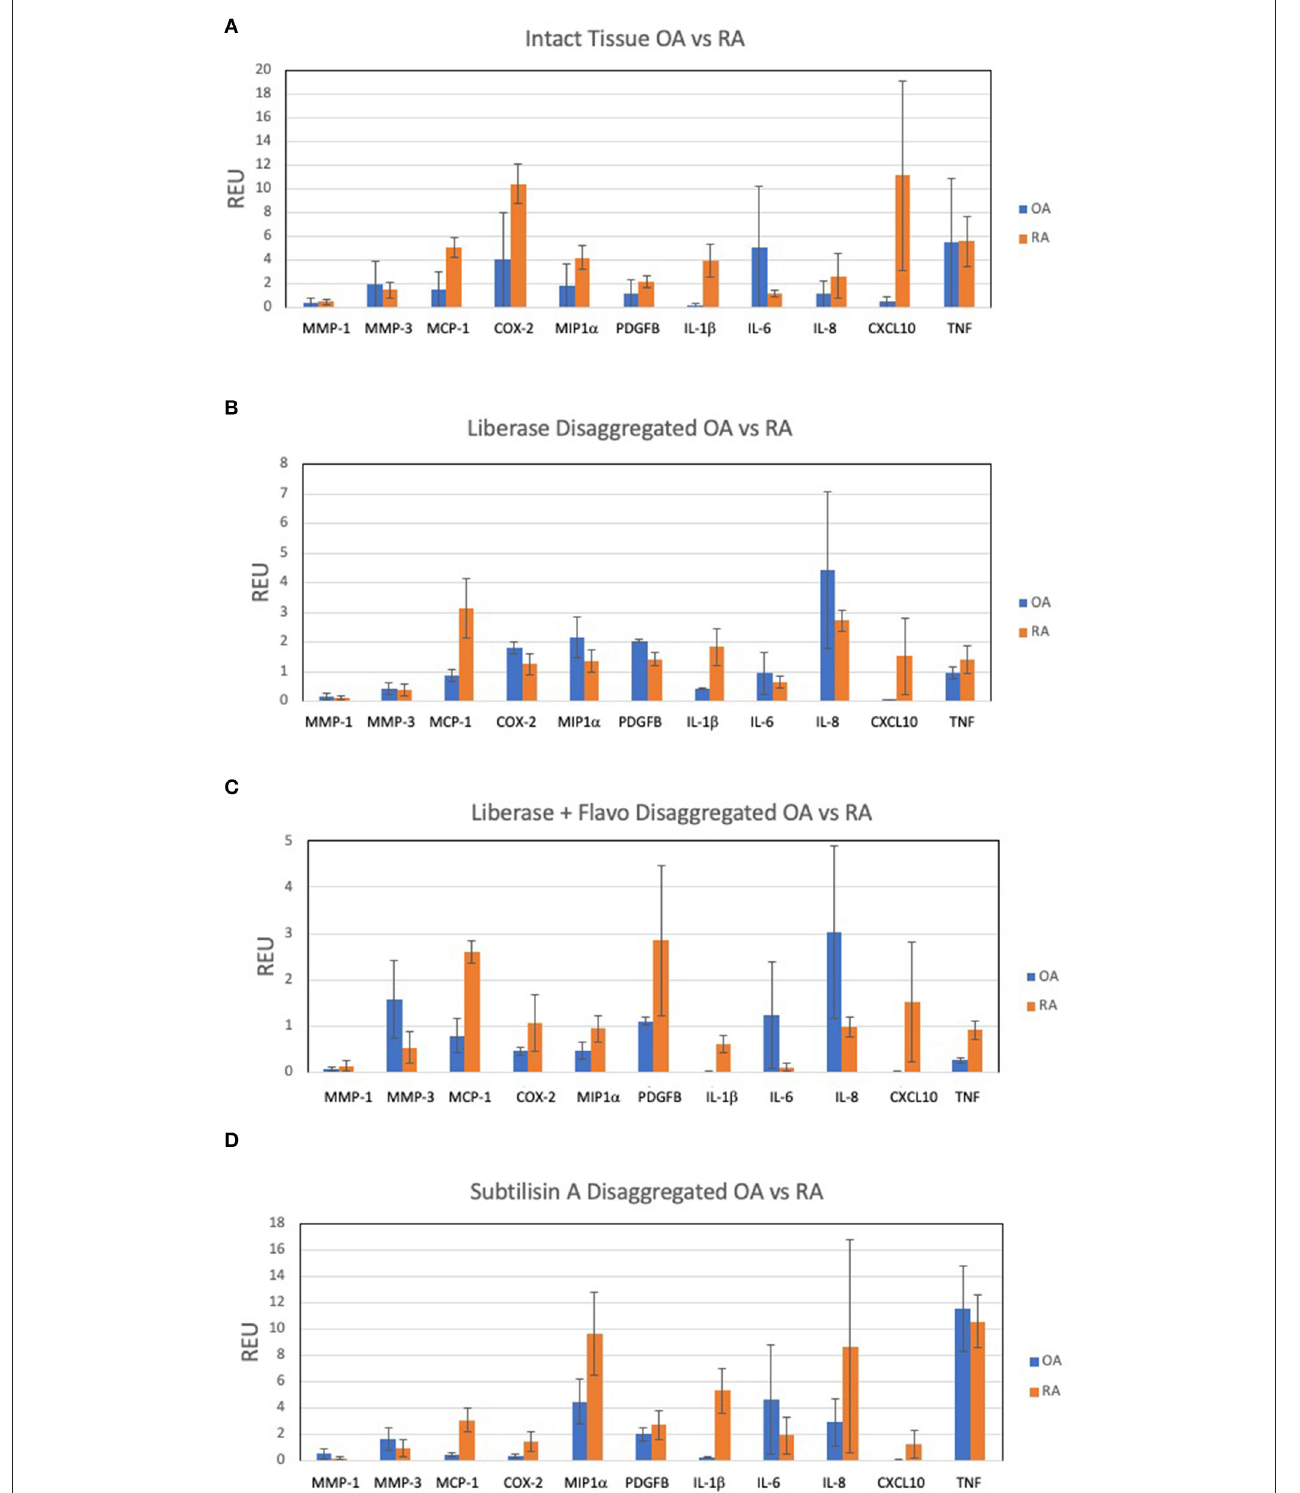
FIGURE 1 | Expression of select 11 transcripts in intact synovia. Selected transcripts were measured by qPCR in replicate pools of intact OA ( n = 10) and RA ( n = 5) synovial tissues from 3 experiments and reported as Relative Expression Units (REU) as previously described (5). The heterogeneity of expression among tissues, markers and disease are notable. (A) OA and RA intact tissue, demonstrating in situ expression pattern. (B) Lib disaggregated OA and RA cells, (C) Lib/Flavo disaggregated OA and RA cells. (D) Subtilison A disaggregated synovial tissue cells.